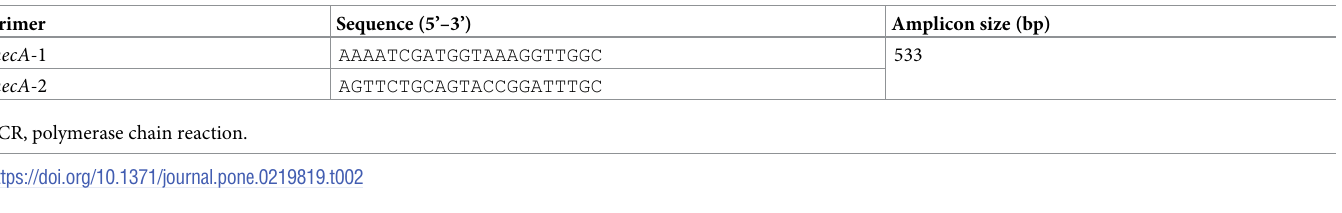
Table 2. Primers used for conventional PCR and direct